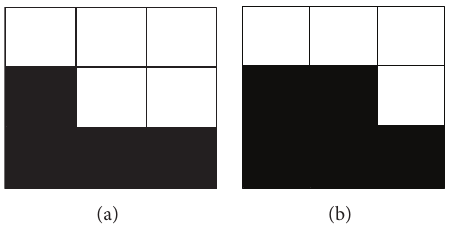
Figure 8: The two 3 ∗ 3 patterns: (a) the pattern 𝑃1 which has four black pixels; (b) the pattern 𝑃2 which has five black pixels. The pattern was calculated by SSIM, so 𝑃1 and 𝑃2 have the highest similarity than other patterns.